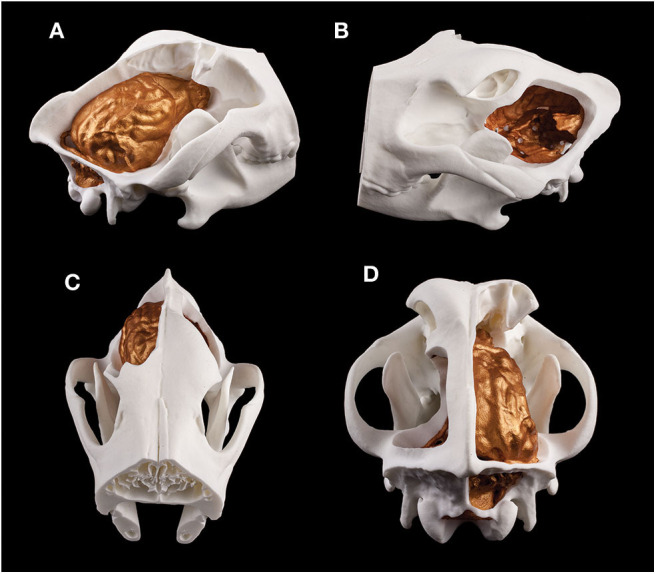
Composite 3D-printed model of a skull and the endocast of a Weimaraner. (A) Right lateral view. (B) Left lateral view. (C) Rostrodorsal view. (D) Caudodorsal view.